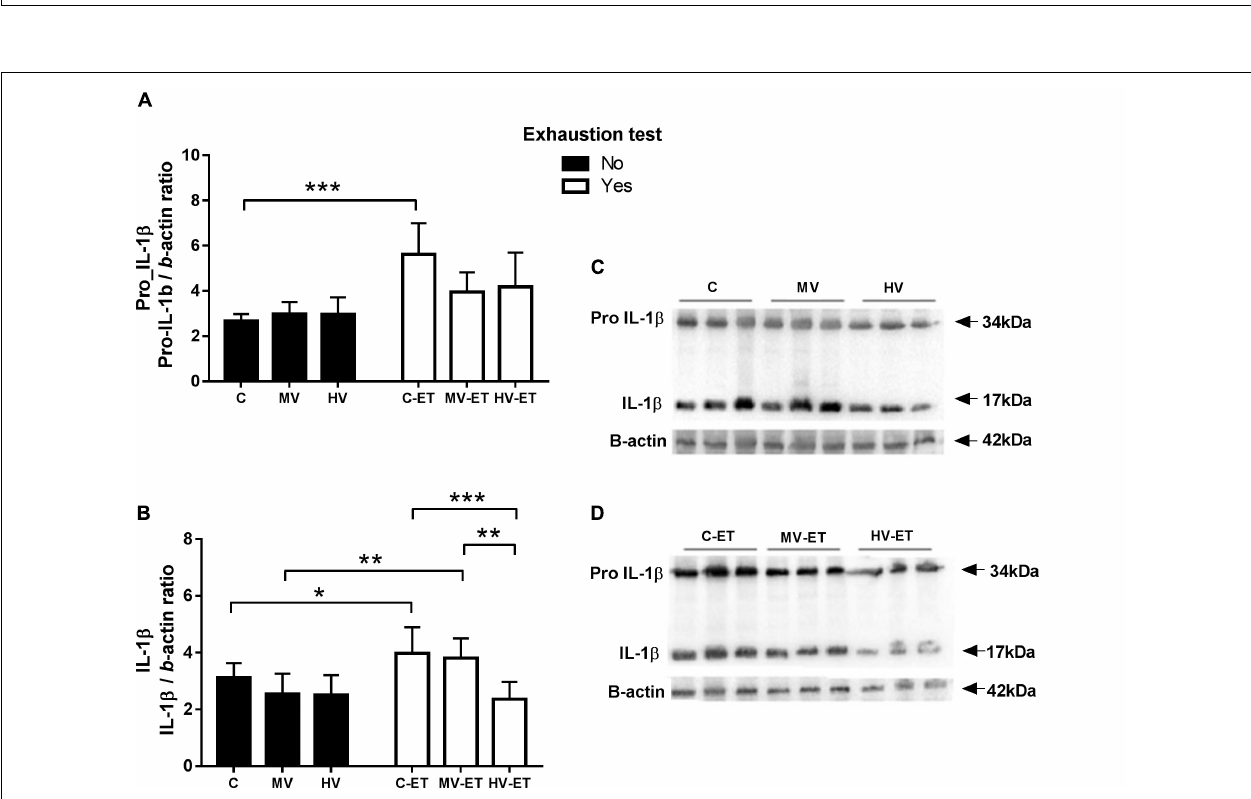
FIGURE 6 | Pro- IL-1B and active IL-1b protein levels assessed by Western blot in the cerebellar tissue. (A) Pro IL-1B: C-ET vs. C ( P < 0.001). (B) IL-1B: C-ET vs. C ( P = c0.046); HV-ET ( P < c0.001). MV-ET vs. MV ( P = 0.006); HV-ET ( P = 0.001). (C) Representative Western blotting membrane of groups without exhaustion test. (D) Representative Western blotting membrane of groups with exhaustion test. C, control group; C-ET, control + exhaustion test group; MV, moderate-volume group; MV-ET, moderate-volume + exhaustion test group; HV, high-volume group; HV-ET, high-volume + exhaustion test group. * P ≤ 0.05; ** P < 0.01; *** P < 0.001. Values represent mean ± S.D. N = 3 independent experiments per group. All the experiments were carried out in triplicate.